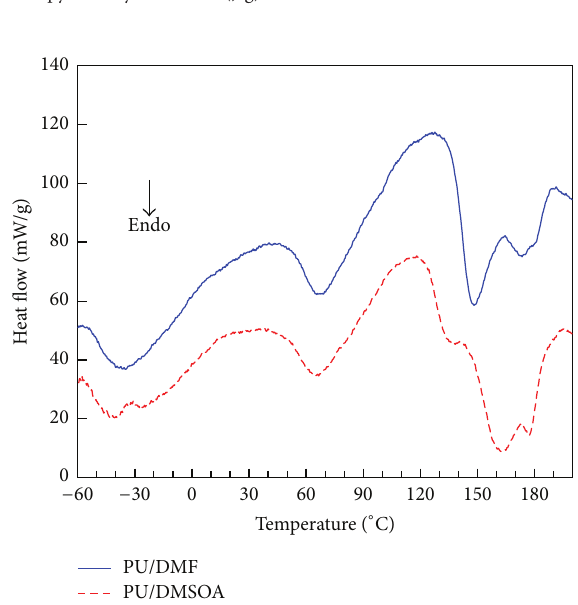
Figure 4: DSC endothermic thermograms of the PU/DMF and PU/ DMSOA samples.